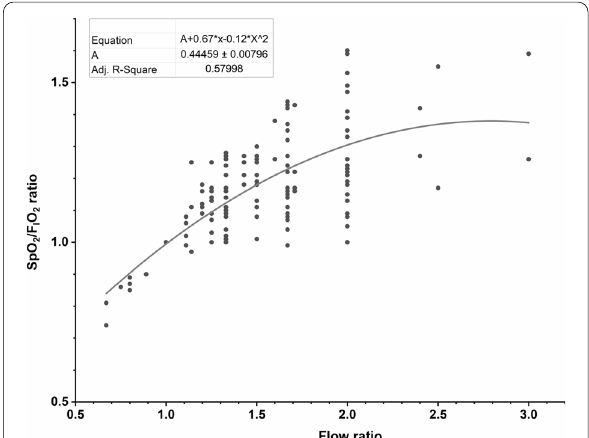
Fig. 1 The correlation between SpO 2 /F I O 2 ratio and flow ratio. The flow ratio of setting HFNC flow to the patient’s peak tidal inspiratory flow is shown on the X-axis. The ratio of patients’ SpO 2 /F I O 2 at one flow setting to SpO 2 /F I O 2 achieved when HFNC flow was set to match patient’s peak inspiratory flow during tidal breathing (matching flow) is shown on the Y-axis. The scatterplot shows significant correlation between the two ratios. SpO 2 , pulse oximetry; F I O 2 , fraction of inspired oxygen; HFNC, high-flow nasal